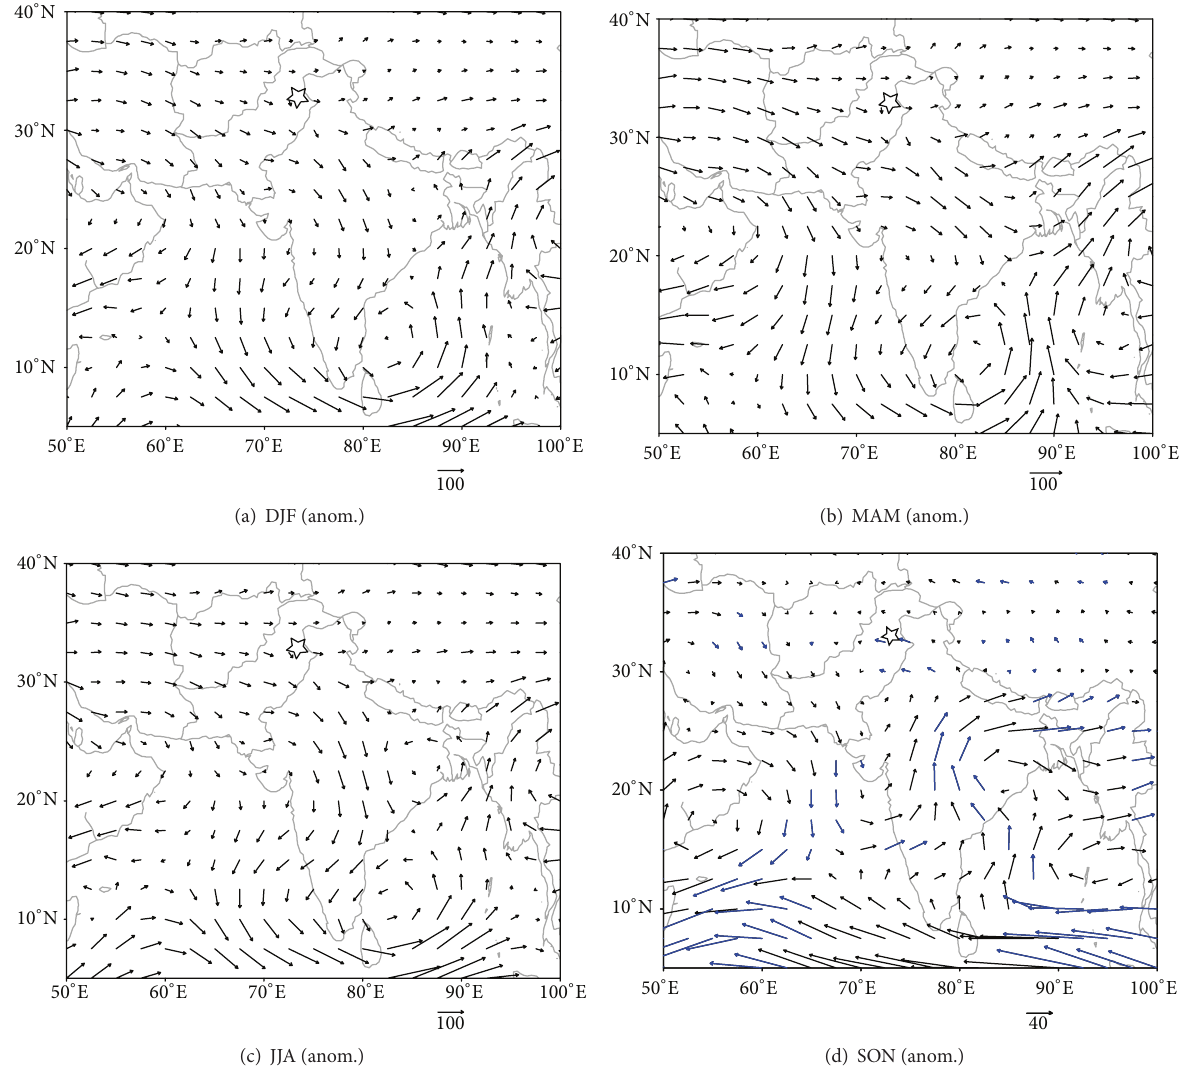
Figure 10: Composite of the vertically integrated (a) winter, (b) spring, (c) summer, and (d) autumn water vapor fluxes (units: kg ⋅ m −1 ⋅ s −1 ) between wet and dry years. Blue arrows indicate that the differences between wet and dry years are significant at the 95% confidence level. A star is showing Islamabad (33.65 ∘ N, 73.26 ∘